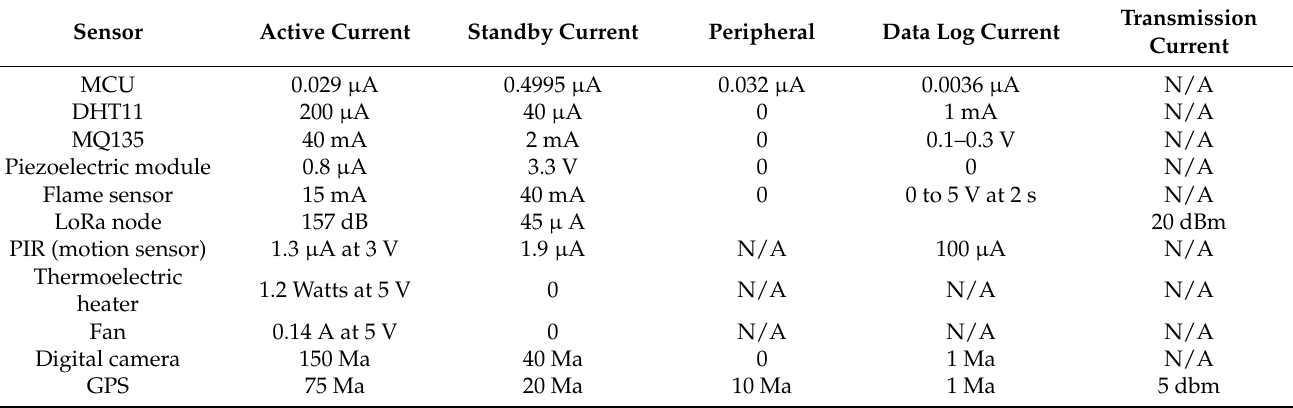
Table 2. Power consumption by SBHMAS sensors and